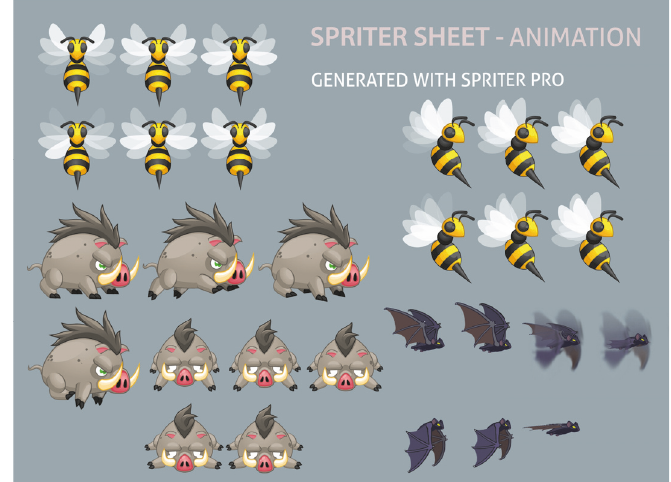
Figure 9: Animation (some enemies) from SpriterPro, by BrashMonkey to Unity.